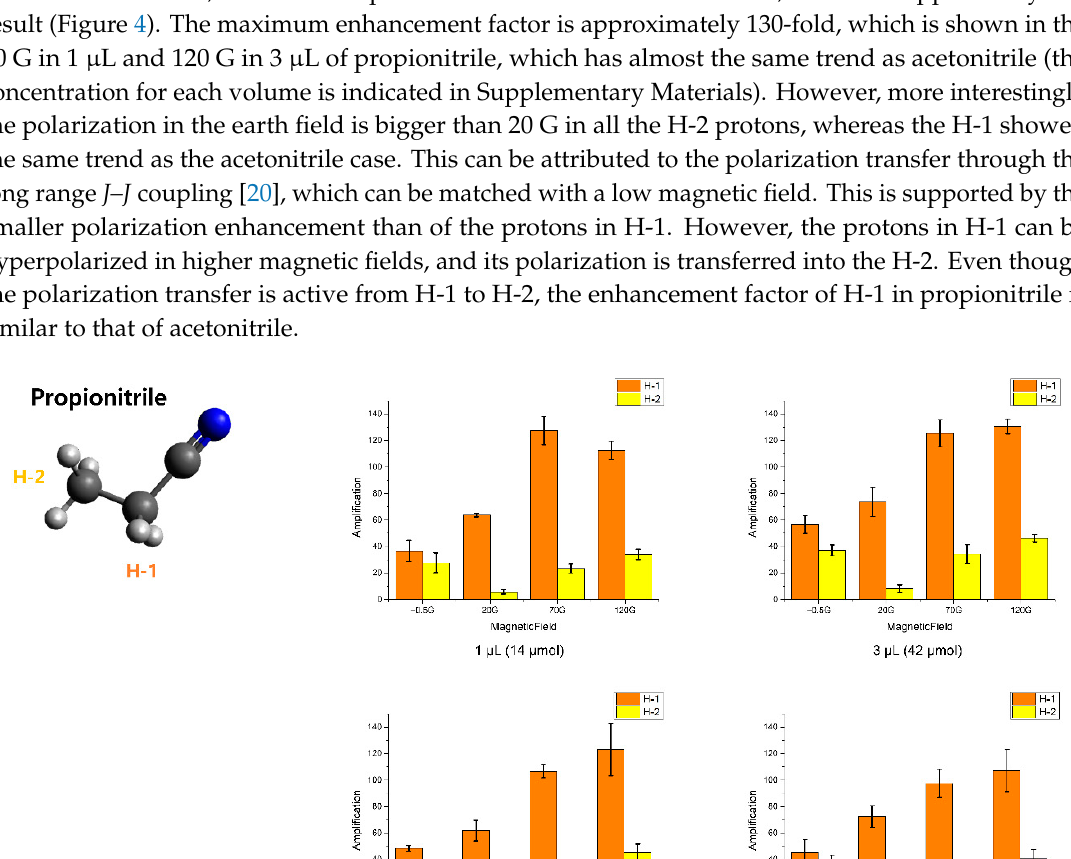
Figure 3. NMR spectrum after SABRE in different magnetic fields on the 1 μ L (19 μ mol) of acetonitrile ( a ) and hyperpolarized spectrum in 70 G ( b ) All other examples of spectra are shown in Supplementary Material.